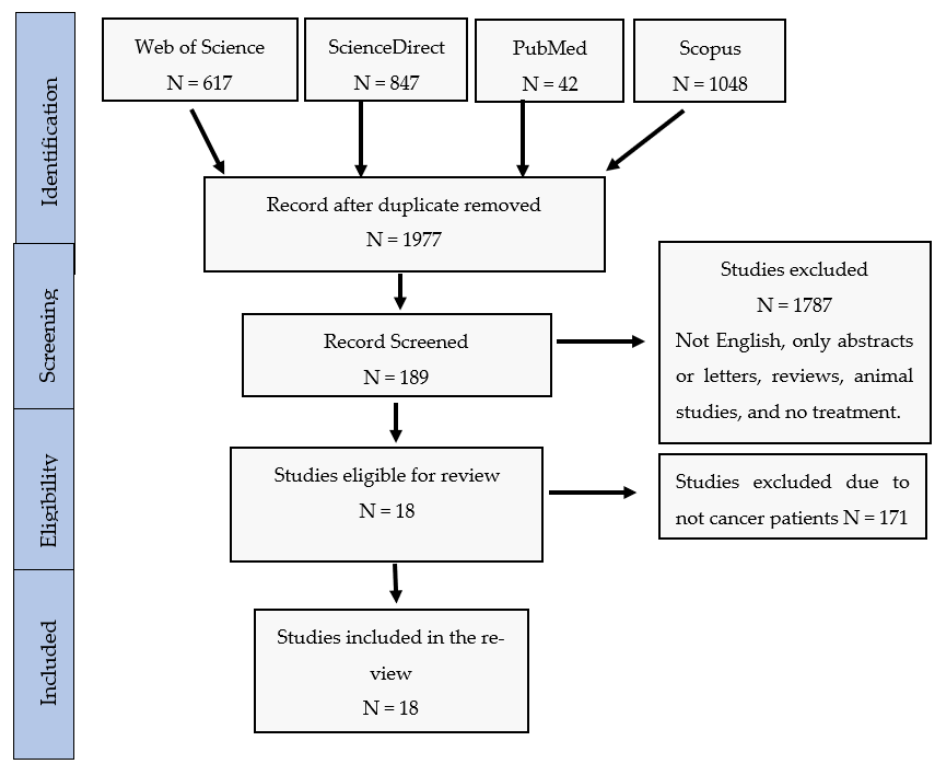
Figure 1. PRISMA Flow chart of study selection.